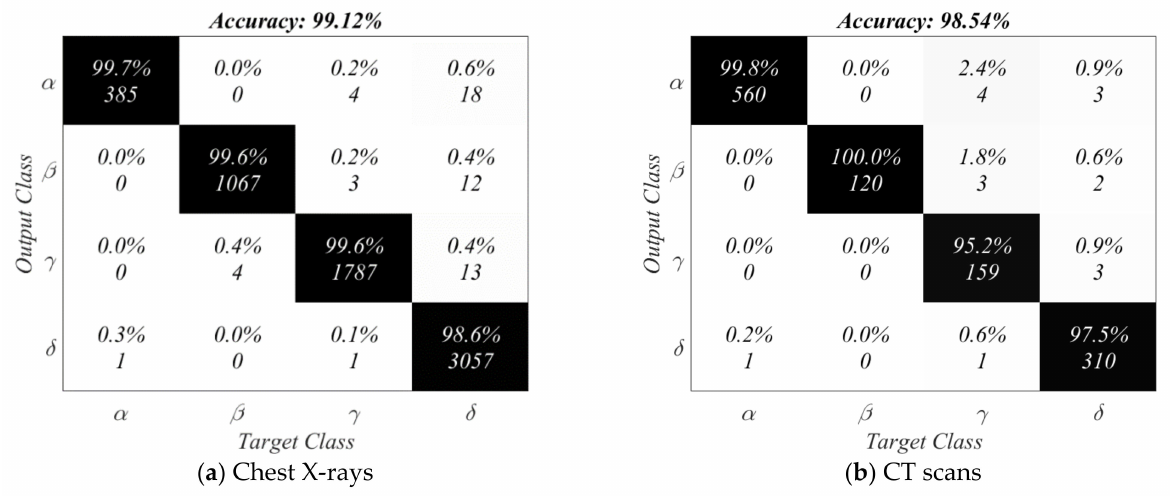
Figure 13. Confusion matrices of the second stage of the proposed framework for ( a ) chest X-rays and ( b ) CT